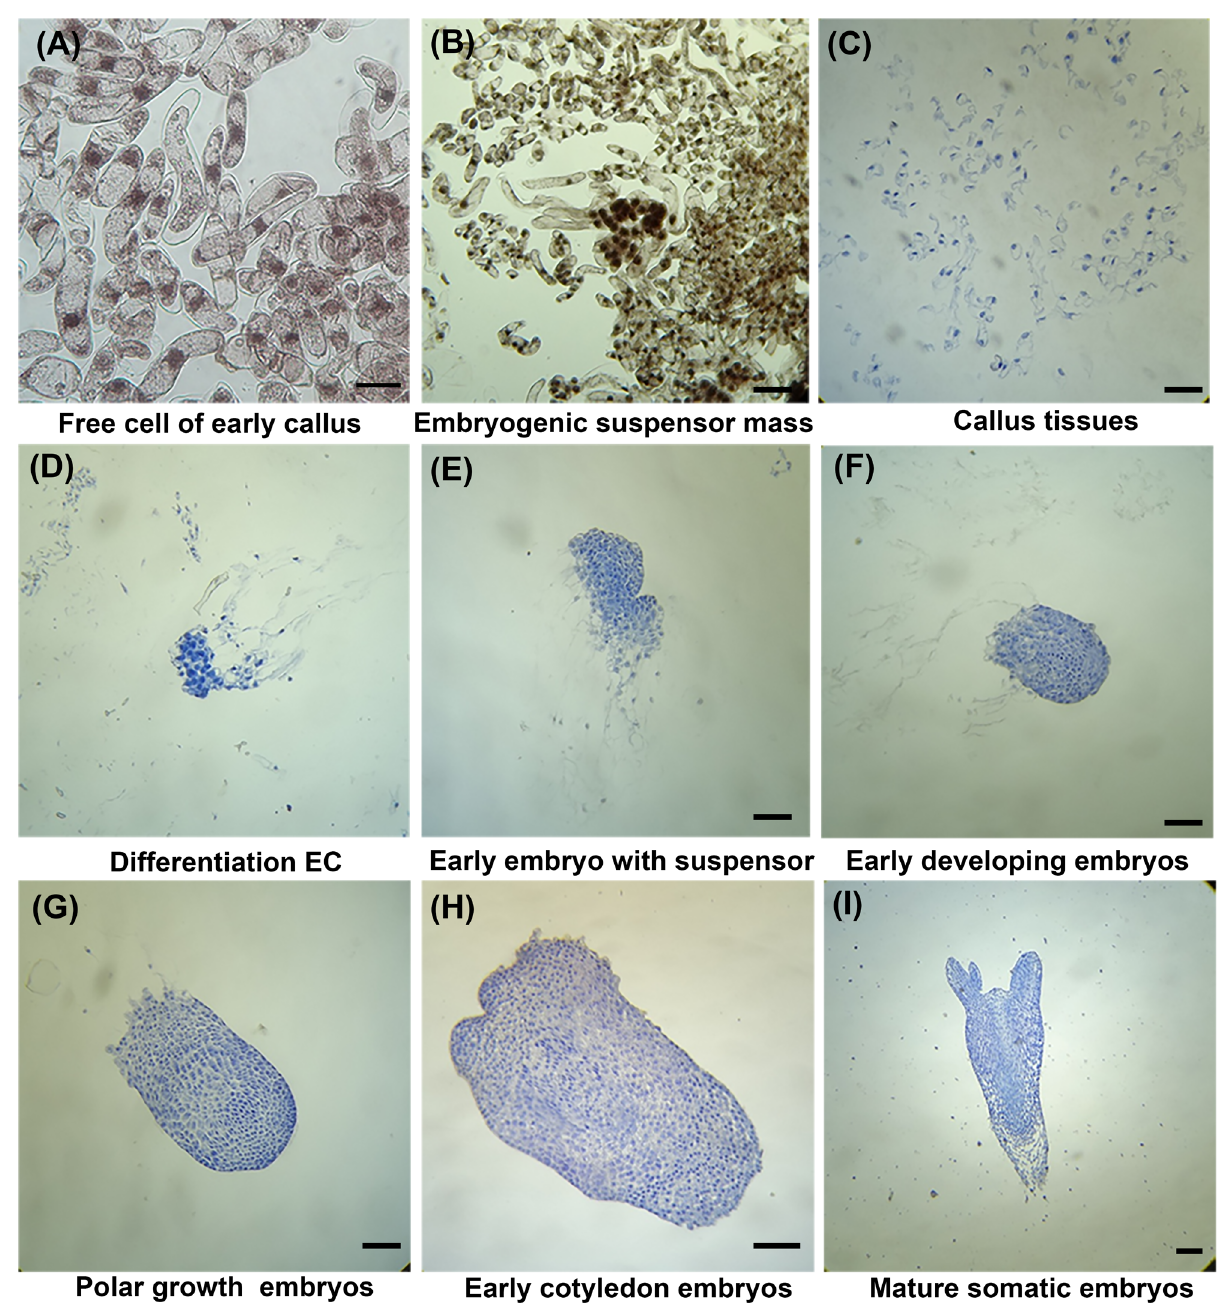
Figure 2. Development stages of somatic embryos in Picea mongolica. ( A , B ) Early embryogenic cultures stained with gentian violet. ( A ) Free elongated suspensor cells from very early initiation of callus after 1 weeks EC induction; Bar: 100 μm. ( B ) Early embryogenic suspensor mass with some free suspensor cells after 2 weeks EC induction; Bar: 50 μm. ( C – I ) Development stages of somatic embryos with cell staining after paraffin sectioning. ( C ) Free suspensor cells in early induced the embryogenic cultures after 2 weeks; Bar: 50 μm. ( D ) Early differentiated embryogenic cultures mass after 3 weeks; Bar: 0.5 mm. ( E ) Embryogenic suspensor mass; Bar: 0.5 mm. ( F ) Early developing embryo disappeared suspensor; Bar: 0.5 mm. ( G ) Developing embryo with polar growth; Bar: 0.5 mm. ( H ) Early cotyledon embryos; ( I ) Mature cotyledon embryos. Bar: 0.5 the early July, most of embryos were at the pro-embryo stage; they developed into early embryogeny in mid-July. After that, most of them developed into late embryogeny (pre or early cotyledonary embryo) in early August; and maturation stage (mature cotyledon embryos) in later August (Table 4). Therefore, EC initiation frequency was likely positively correlated with the embryo’s developmental stages. Moreover, EC induction frequency was 74% and 12%, when pre-cotyledons and mature cotyledon embryos as explants, respectively. All these results showed that the developmental stage of the initial zygotic embryo is essential for embryo meristem initiation.